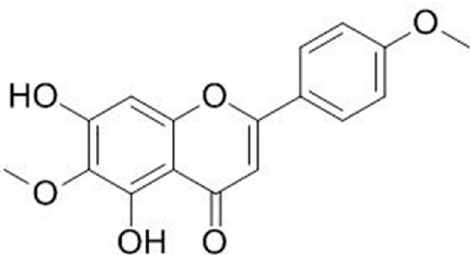
Figure 1. Pectolinarigenin isolated from Artemisia cina CO 2 subcritical extract. Table 1 . 1 H- and 13 C-NMR data of pectolinarigenin (600 MHz for 1 H-NMR and 125 MHz for 13 C- NMR, CDCl3). The data collected from published papers were used to confirm that the structure of the flavonoid isolated.